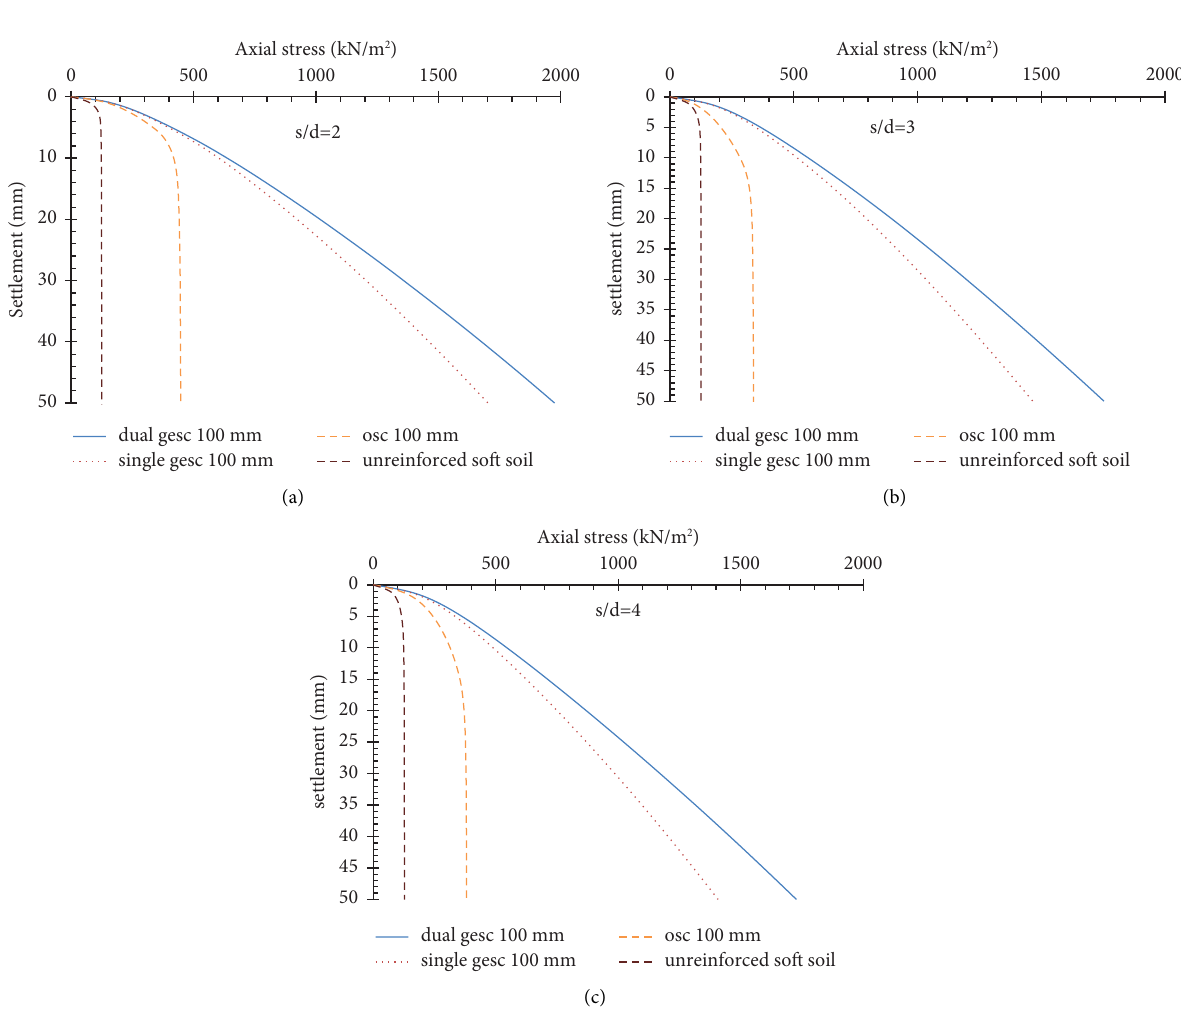
Figure 7: Axial stress vs. settlement of single column: (a) s / d � 2, (b) s / d � 3, and (c) s / d �